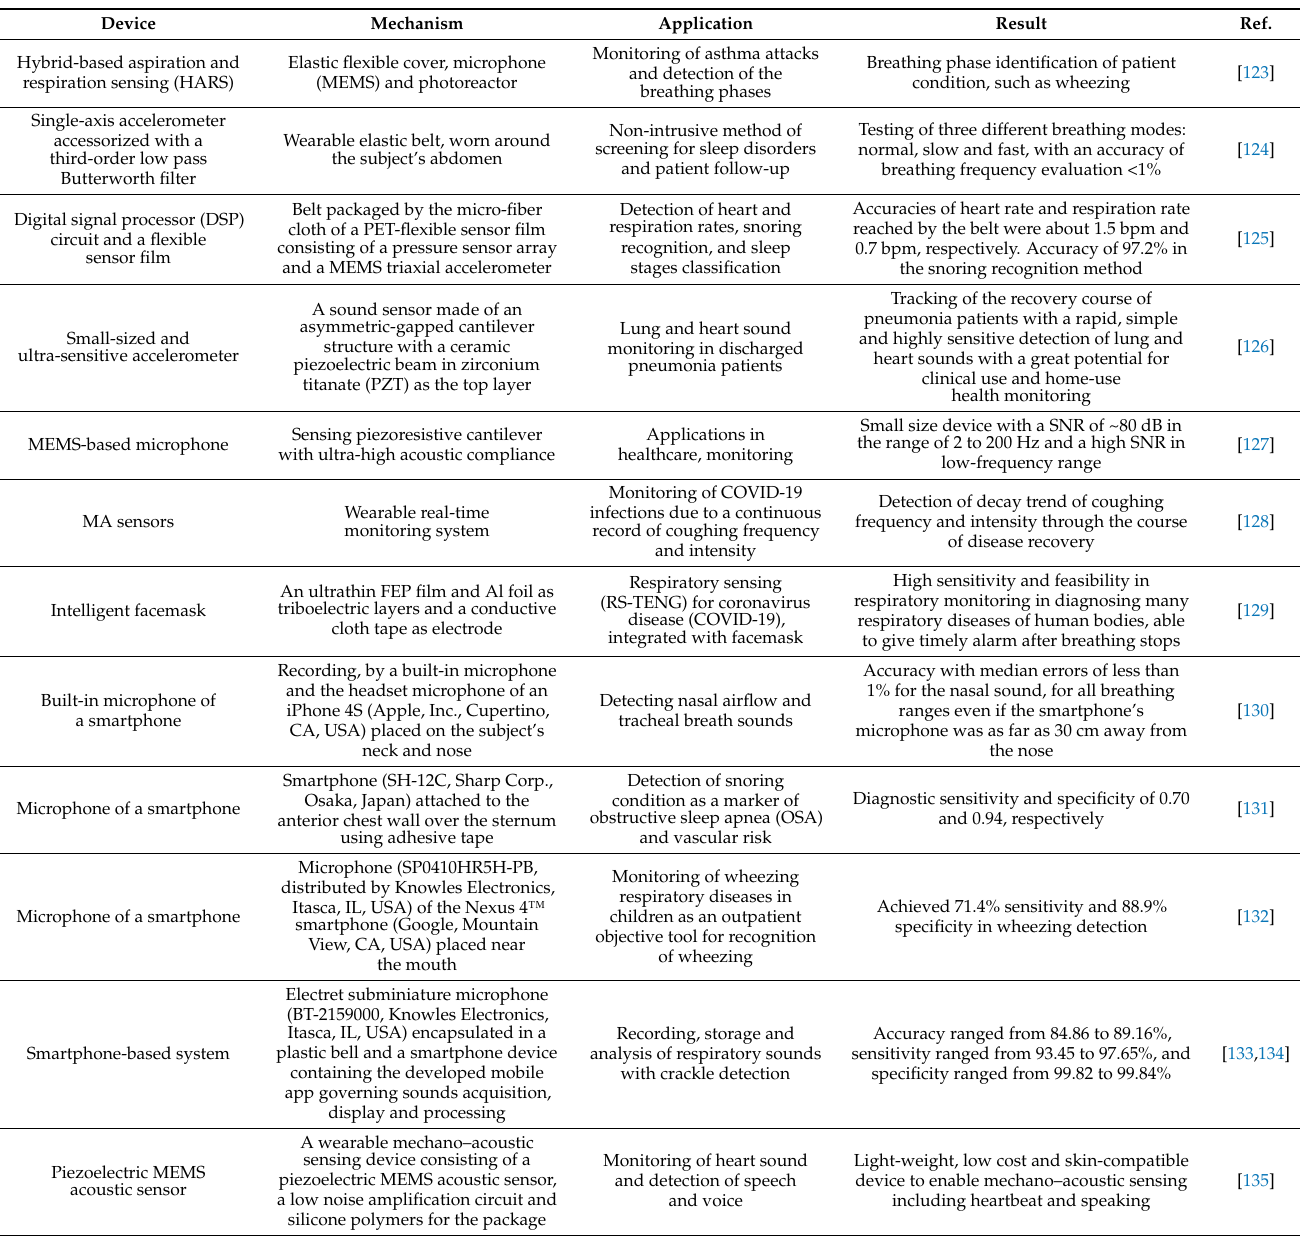
Table 4. Sensor equipment for respiratory sound monitoring